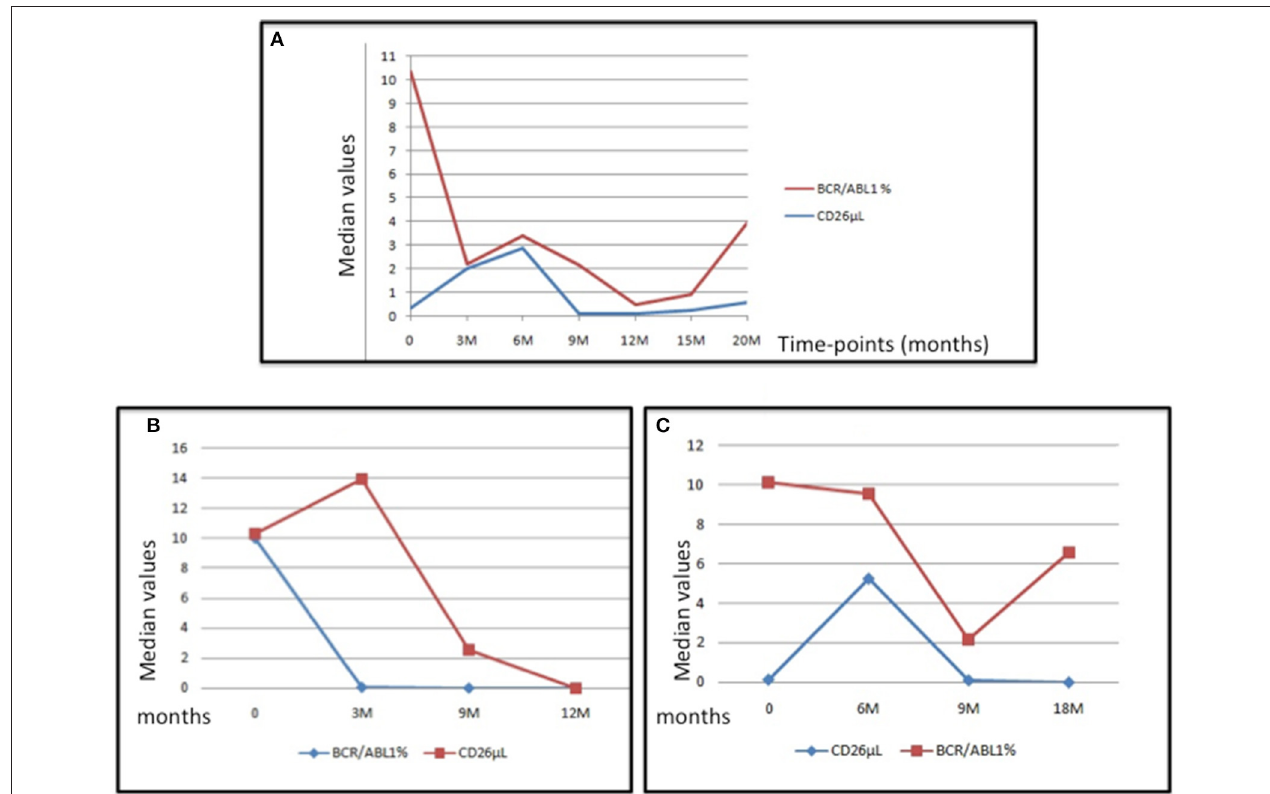
FIGURE 3 | The Figure represents the median values of CD26 + cells and of the BCR-ABL1/ABL1 transcript at diagnosis and during treatment with imatinib in the whole series (box A ), in an “optimal” case (box B ), and in a “warning” case (box C ).